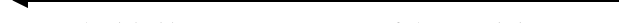
Fig. 6. A nightside pass over a source of AKR emissions on 10 November 1996. The figure has been constructed from several spectrograms, similar to those of Fig. 4, without taking into account the time gaps. The UT times which are indicated are exact but the time interval between two time marks may vary. The units are arbitrary (see